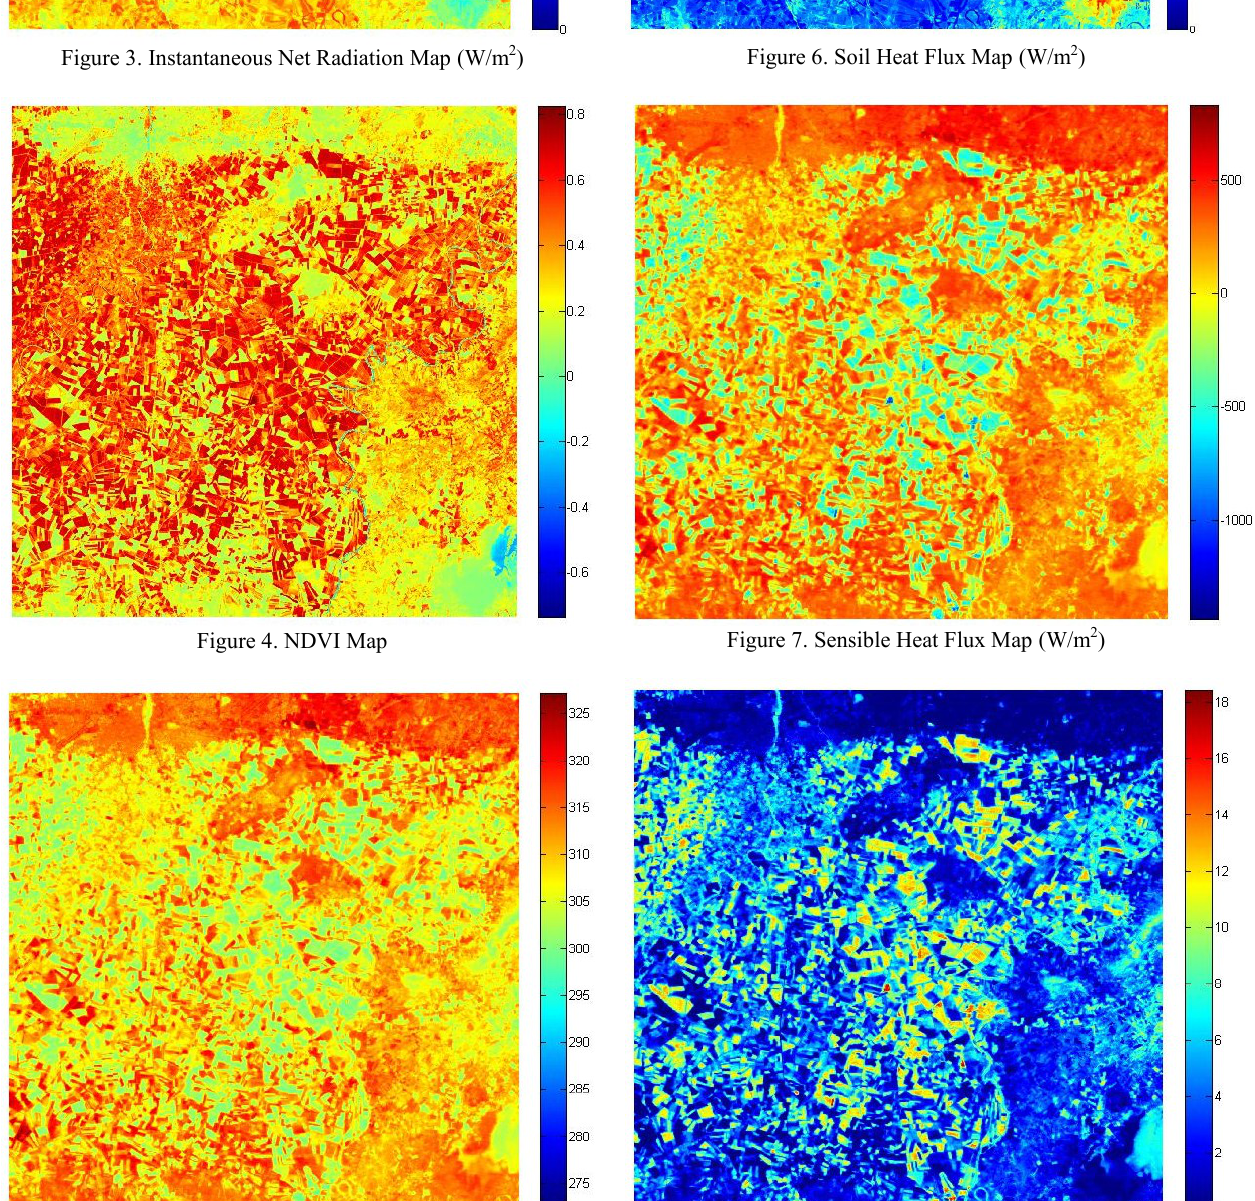
Figure 5. Surface Temperature Map (Kelvin)